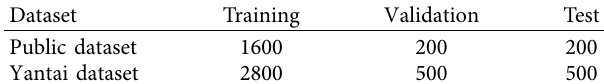
Table 1: Public dataset and Yantai